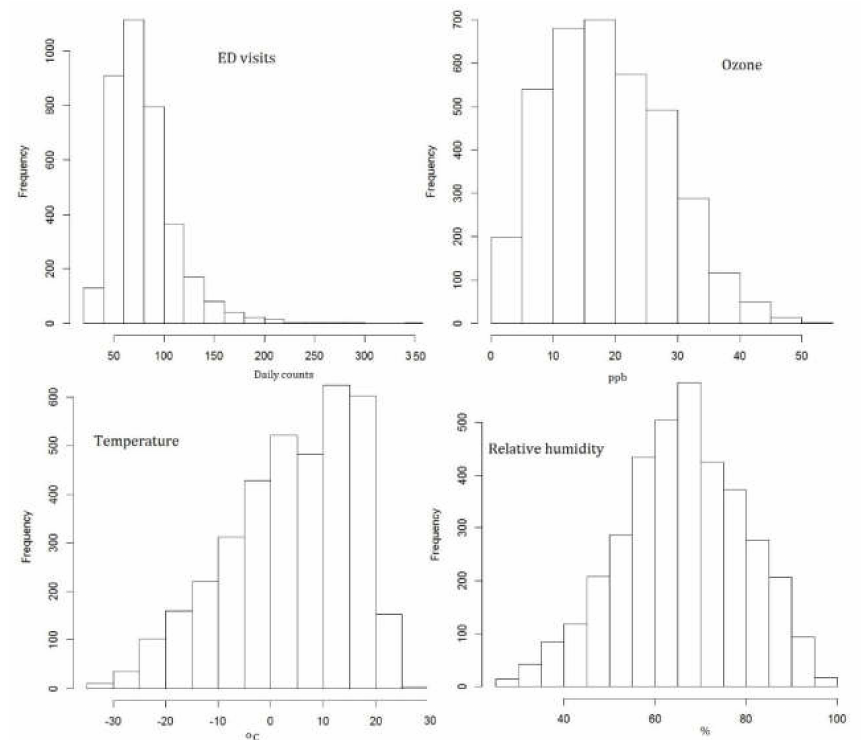
Figure 1. Daily values during the study period (3652 days). Histogram of ED visits (daily counts), ozone (ppb), temperature ( ◦ C), and relative humidity (%).